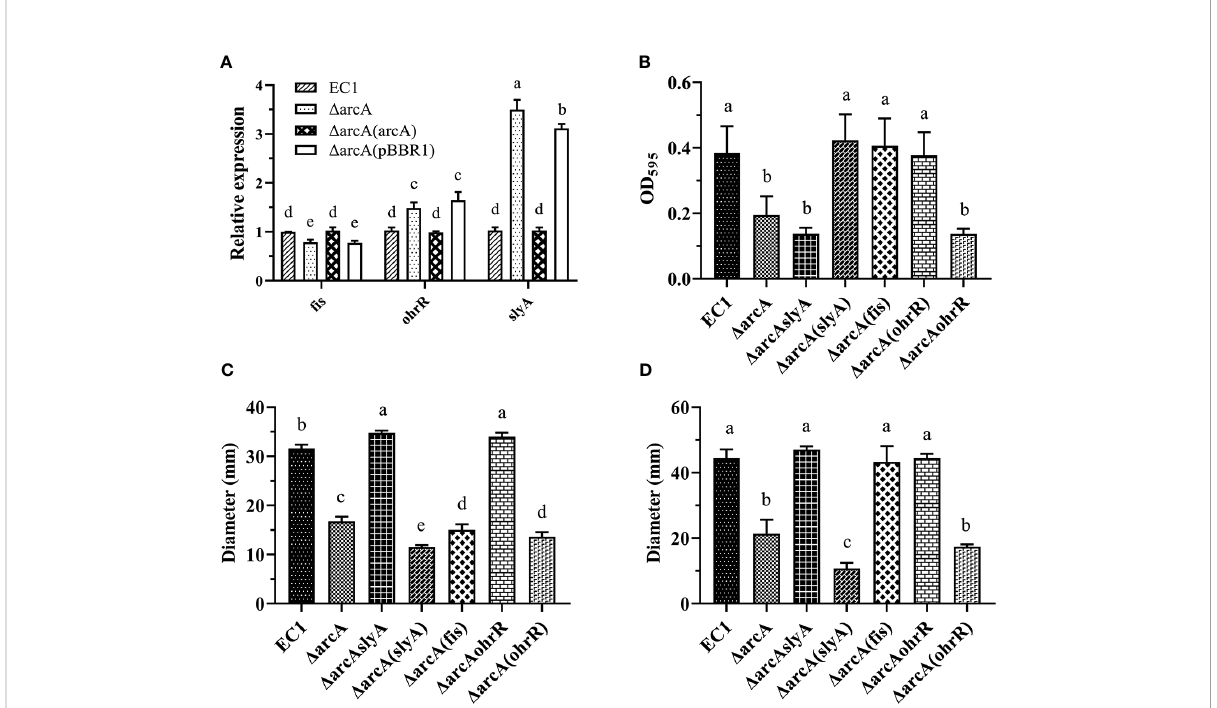
FIGURE 6 ArcA regulates the expression of fi s positively, and slyA and ohrR negatively. (A) The expression of fi s , slyA , and ohrR in the arcA deletion mutant. (B) The bio fi lm formation by wild-type strain EC1, D arcA, D arcAslyA, D arcA(slyA), D arcA( fi s) and D arcA(ohrR). (C) Swimming motility of wild-type strain EC1, D arcA, D arcAslyA, D arcA(slyA), D arcA( fi s) and D arcA(ohrR). (D) Swarming motility of wild-type strain EC1, D arcA, D arcAslyA, D arcA(slyA), D arcA( fi s) and D arcA(ohrR). The experiments were repeated three times in triplicate. Statistical analysis was performed on each group of data and signi fi cantly different values (analysis of variance, p < 0.05) are indicated by different